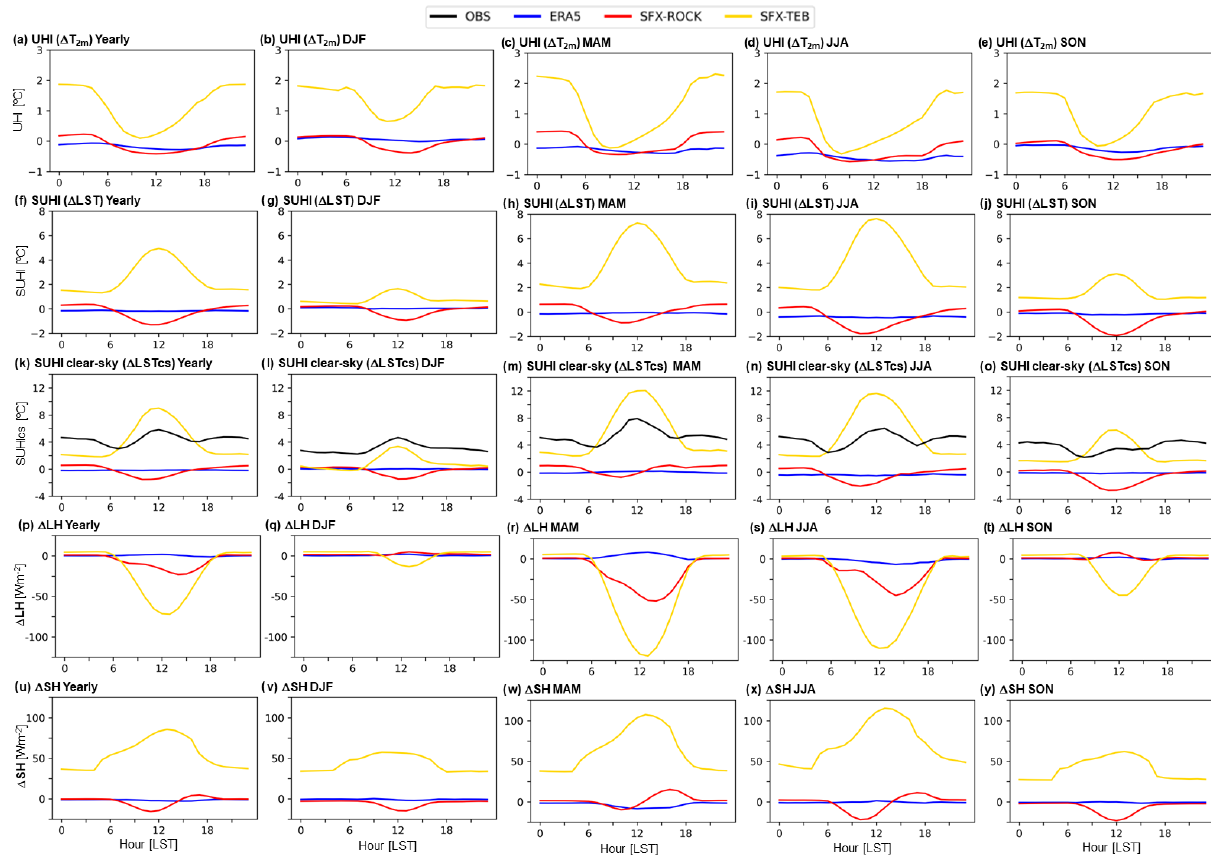
Figure 11. Average diurnal cycle of UHI (a–e) , SUHI under all-sky conditions (f–j) , SUHI under clear-sky conditions (k–o) , (cid:49) LH (difference between surface latent heat flux between urban and rural areas; p–t ), and (cid:49) SH (difference between surface sensible heat flux between urban and rural areas; u–y ). The columns, from left to right, represent averages taken over full year, DJF, MAM, JJA, and SON. The average diurnal cycles were computed over the 2004–2018 period. The different colors represent LSA-SAF (black), ERA5 (blue), SFX-ROCK (red), and SFX-TEB